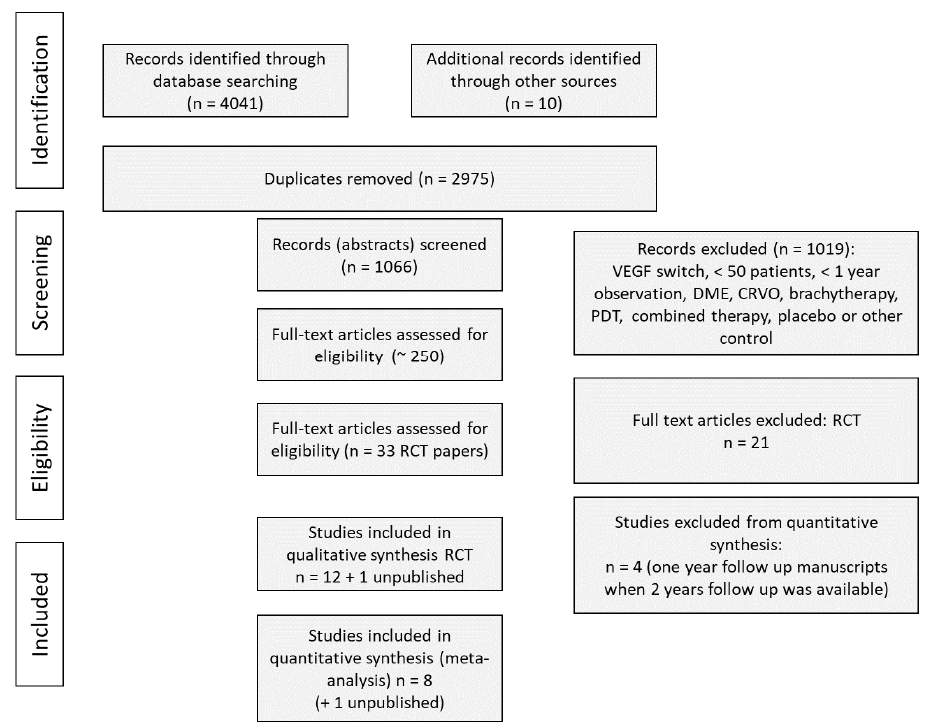
Figure 1. Study flow diagram Preferred Reporting Items for Systematic Reviews and Meta-Analyses (PRISMA) showing number of trials identified, included, excluded and reason for exclusion.* -.